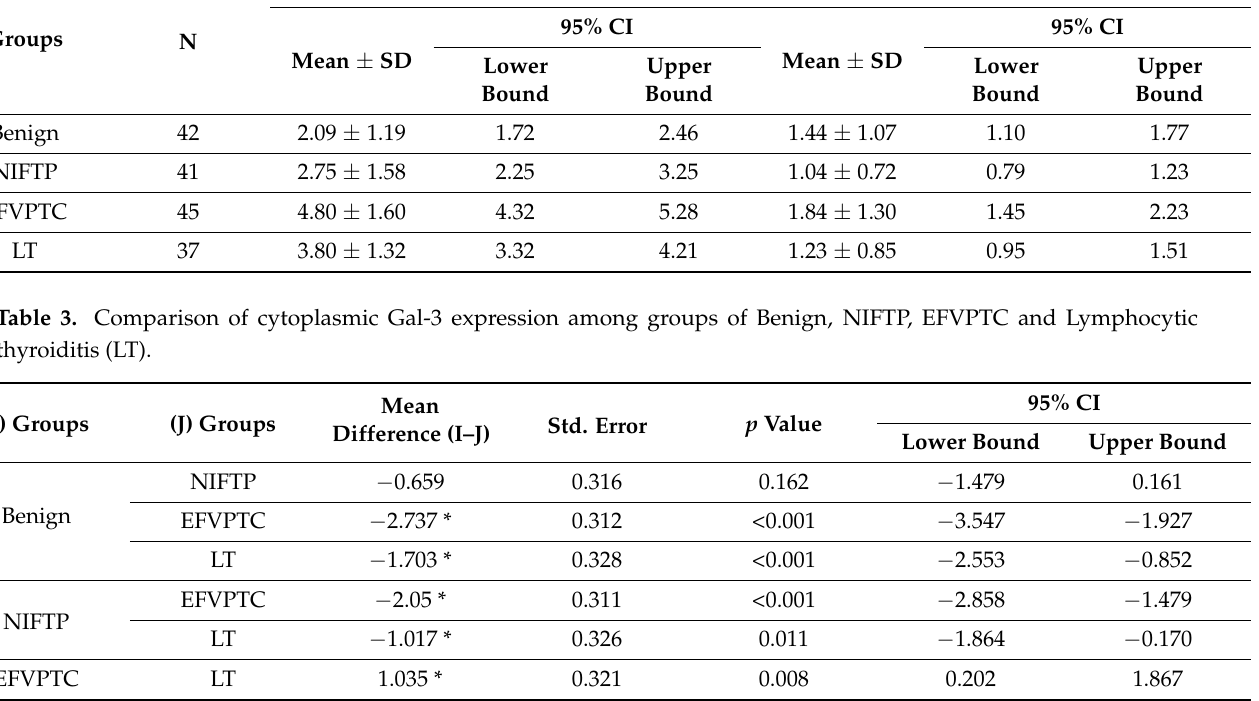
Table 4. Comparison of nuclear Gal-3 expression among Benign, NIFTP, EFVPTC and Lymphocytic thyroiditis (LT).